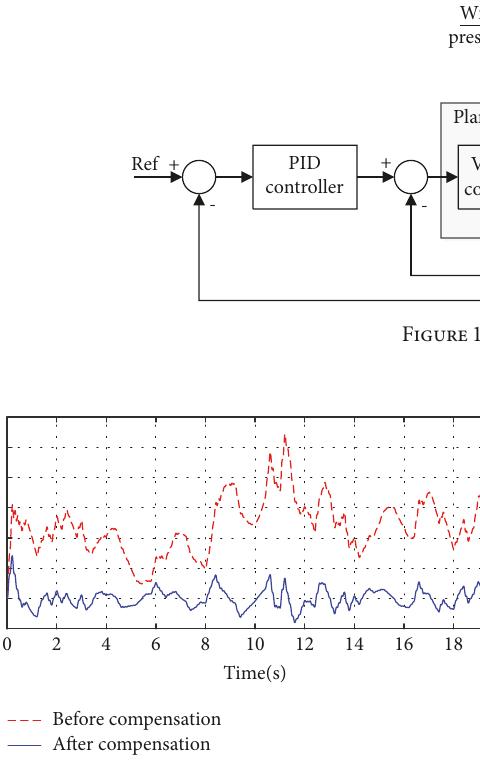
Figure 16: The pointing performance after